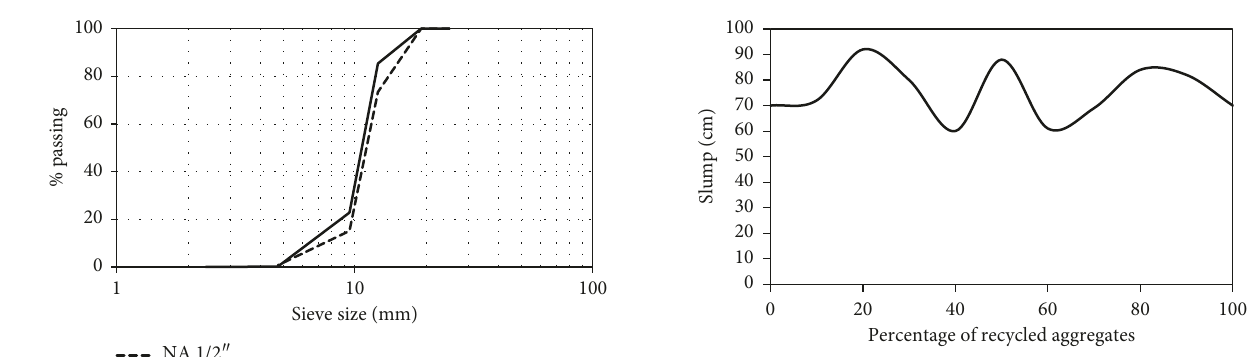
Figure 4: Slump test results for all mixes.